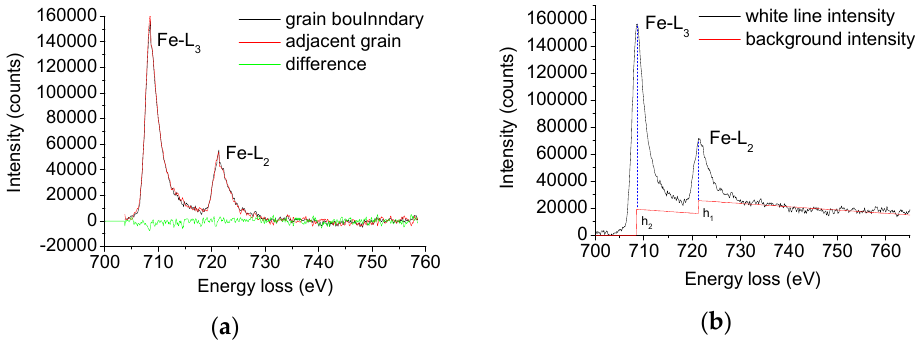
Figure 6. ( a ) Electron energy loss spectra (EELS) profiles of grain and grain boundary in X70 steel and ( b ) double step continuum mode.